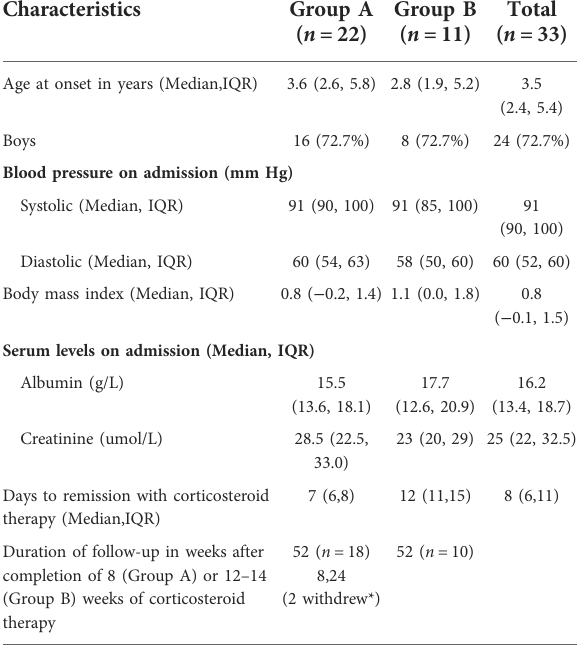
TABLE 2 Baseline characteristics and duration of follow-up.